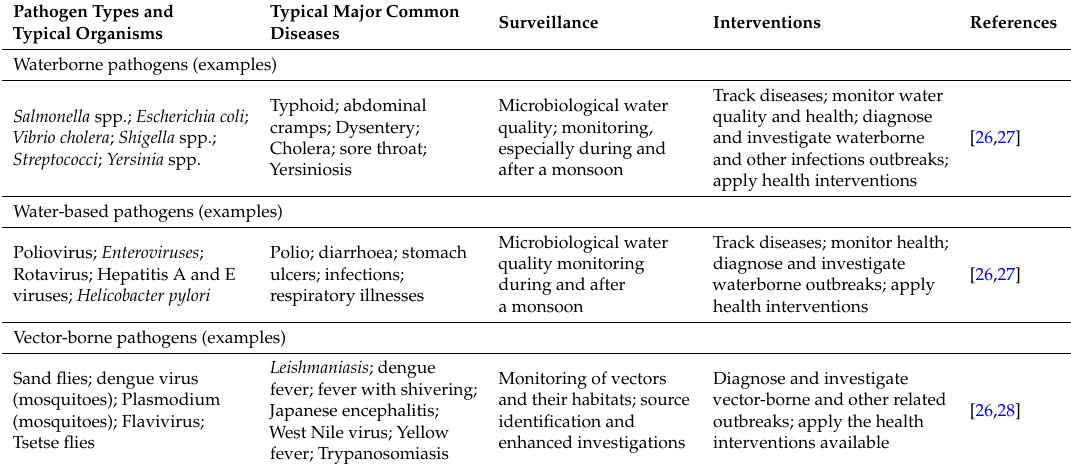
Table 2. Overview of water-related pathogens (both waterborne and vector-borne), diseases, and their